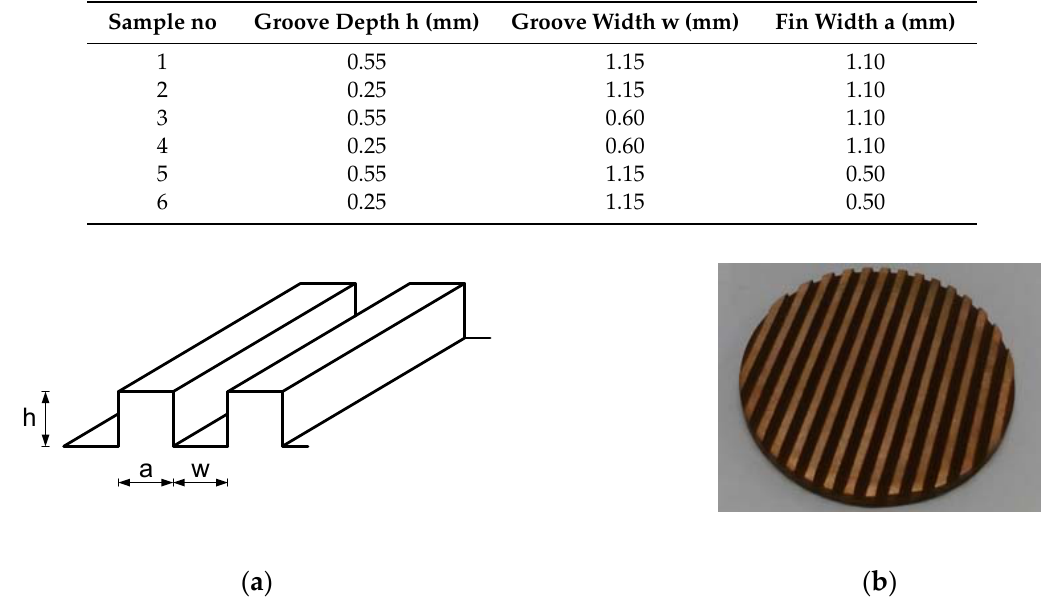
Table 1. Details of the geometrical parameters of the samples.